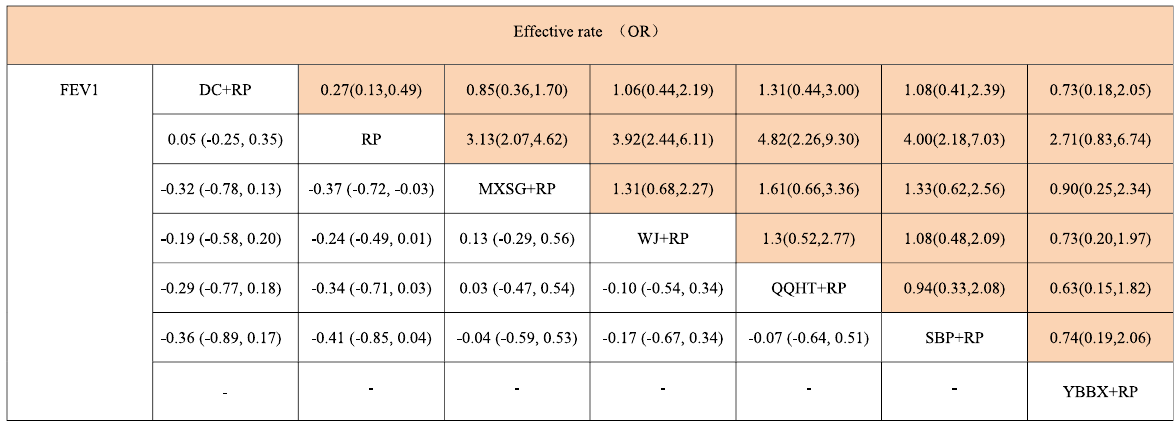
Fig. 3. The results of the network meta-analysis showed significant differences in the five formulas, when com- pared to the use of pharmacotherapy alone (OR 3.13,